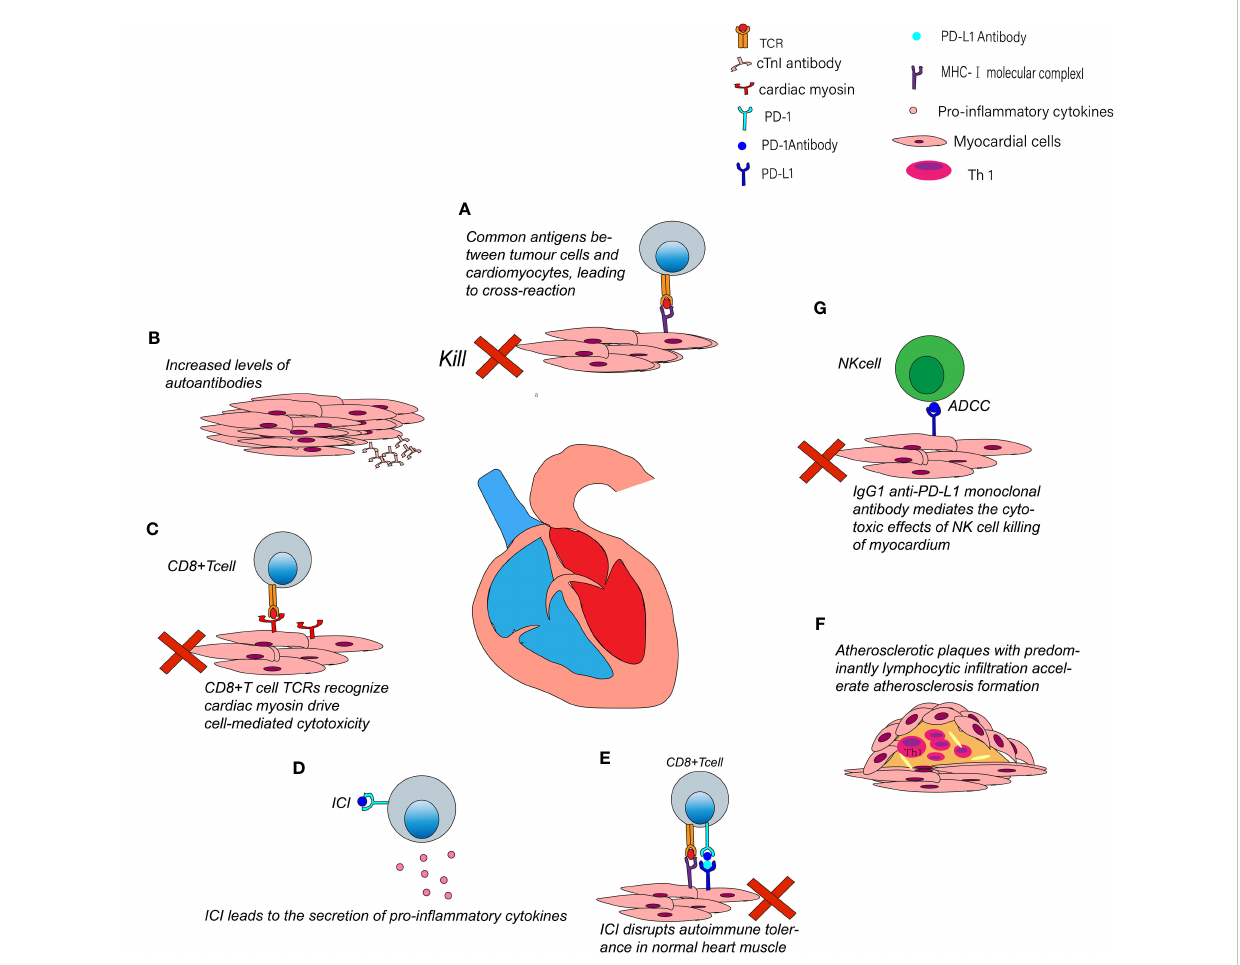
FIGURE 2 Possible mechanisms of CV-irAE. (A) Activated T cells not only attack tumor cells but also cross-reactivate with cardiac muscle. (B) Cardiac myocytes secrete cTnI antibodies after using ICIs. (C) Myosin-speci fi c T cells TCRs can recognize myosin and drive cytotoxic T-cell-mediated killing. (D) ICIs can lead to increased levels of pro-in fl ammatory cytokines. (E) Systemic application of ICI may disrupt immune homeostasis between cytotoxic T cells and Tregs. (F) ICIs may contribute to plaques progression and coronary events. (G) Anti-PD-L1 monoclonal antibodies may mediate NK cells killing cardiomyocytes through the ADCC